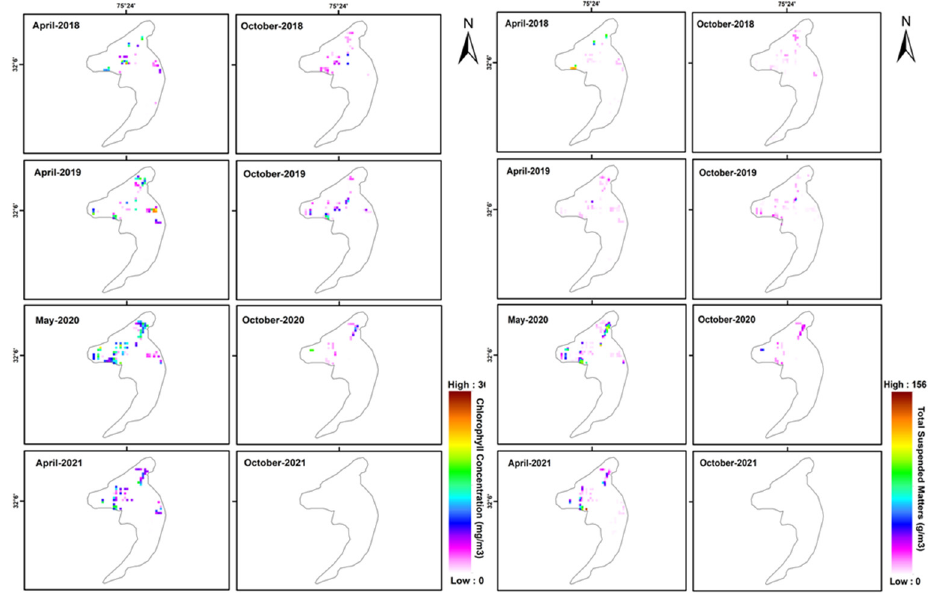
Figure 4. Spatial and temporal variations of chlorophyll concentration ( left side) and total sus- pended matter ( right side) over Harike during Pre- and Post-monsoon season from 2018 to 2021.